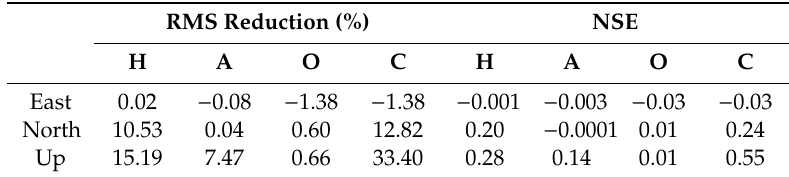
Table 4. Comparison the RMS reduction and Nash–Sutcli ff e e ffi ciencies (NSEs) between rCMEs and loading deformation for three